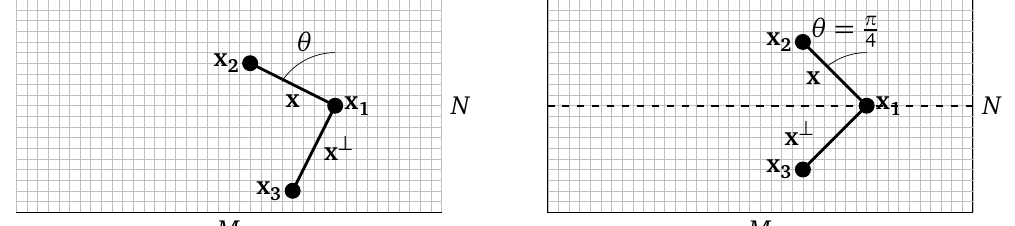
Figure 4: Left: We take three points x , x , x on the torus lattice (cid:90) 2 / ( N (cid:90) × M (cid:90) ) 1 2 3 − x = x and x − x = x ⊥ , see (13). We measure p such that x 2 1 3 1 defined in (10). Right: When θ = π/ 4, x and x ⊥ are symmetric by reflection with respect to the axis parallel to the M axis and passing through x ( x ) = p ( x ⊥ ) for θ = π/ implies p 12 12